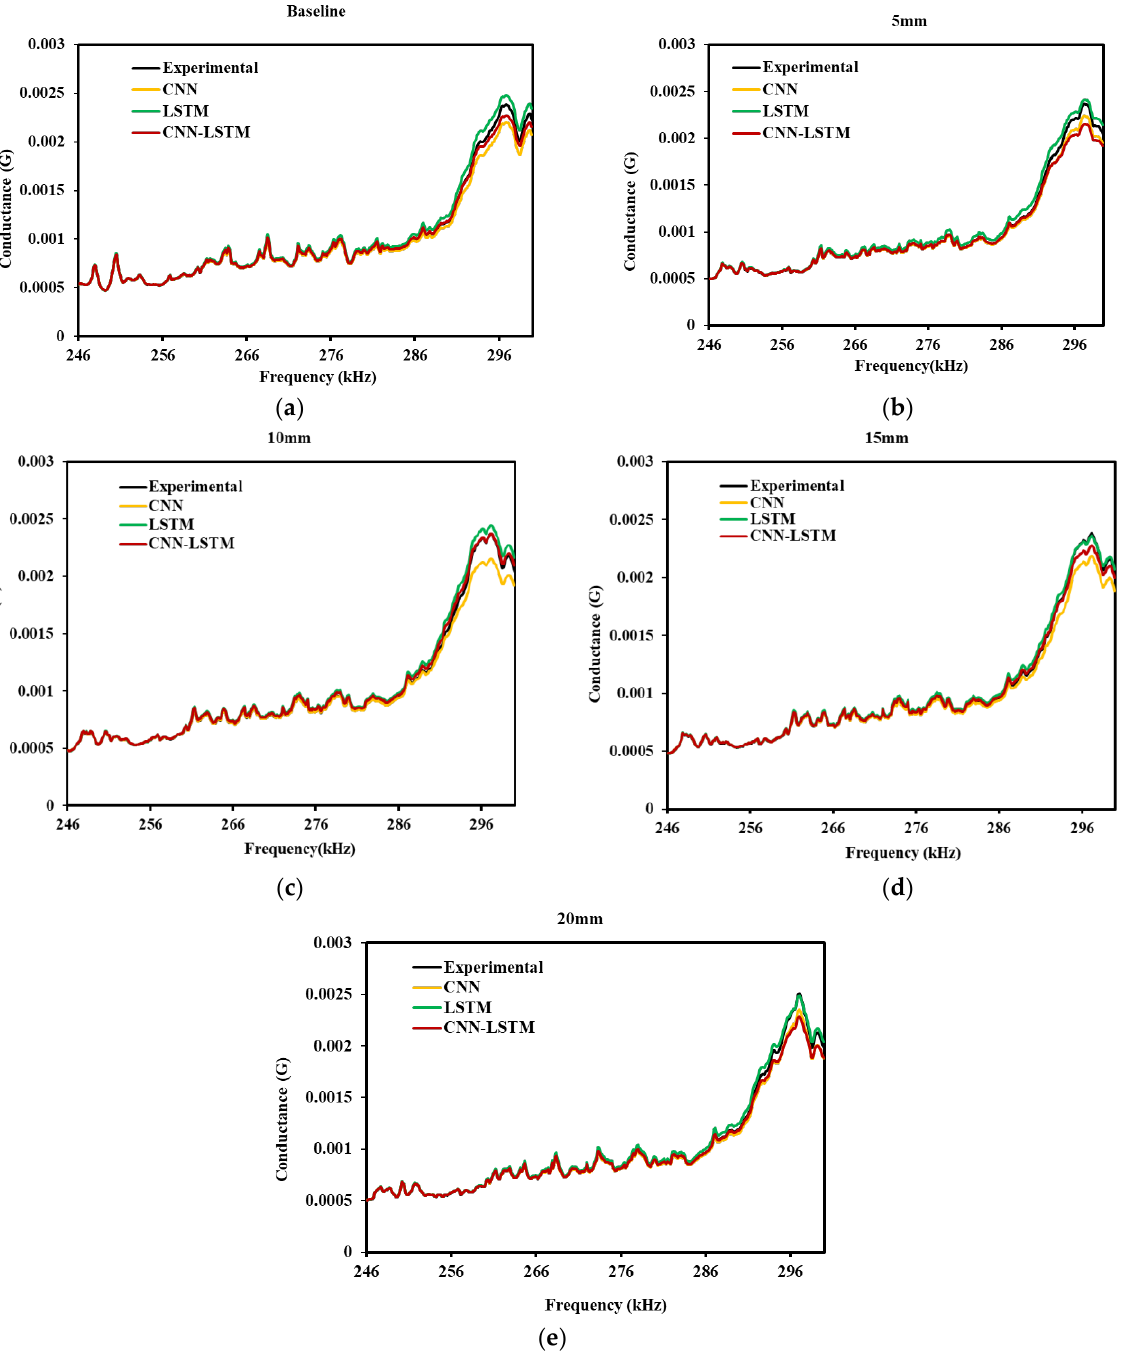
Figure 15. Experimental and predicted deep learning models comparison of Sample 2 ( a ) Baseline, ( b ) 5 mm, ( c ) 10 mm, ( d ) 15 mm, ( e ) 20 mm.